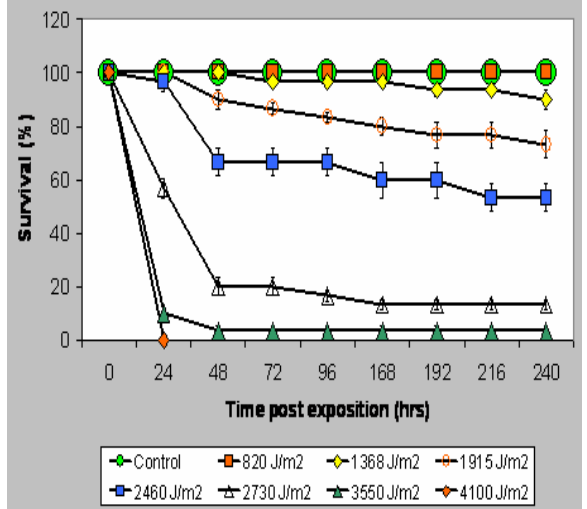
Figure 1: Dose response curves of UV-B radiation